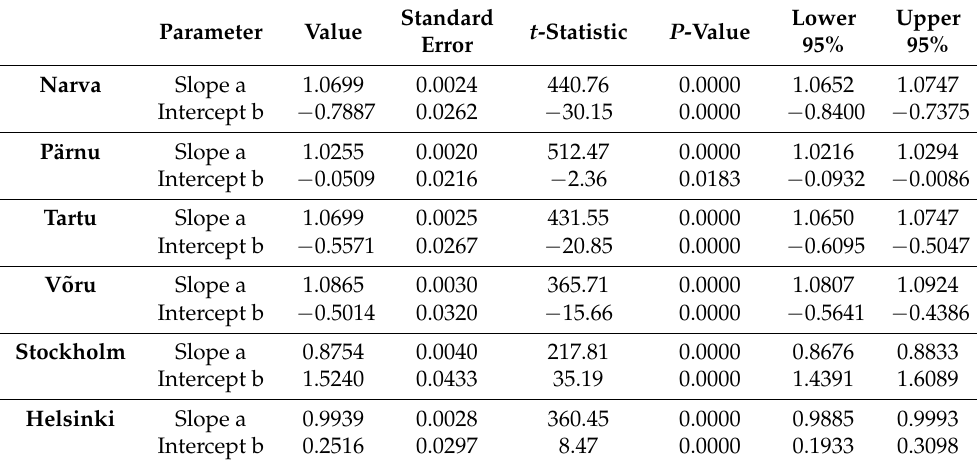
Table 4. Correlations between the average daily surface air temperatures in the different cities and the average daily air temperature in Tallinn—regression